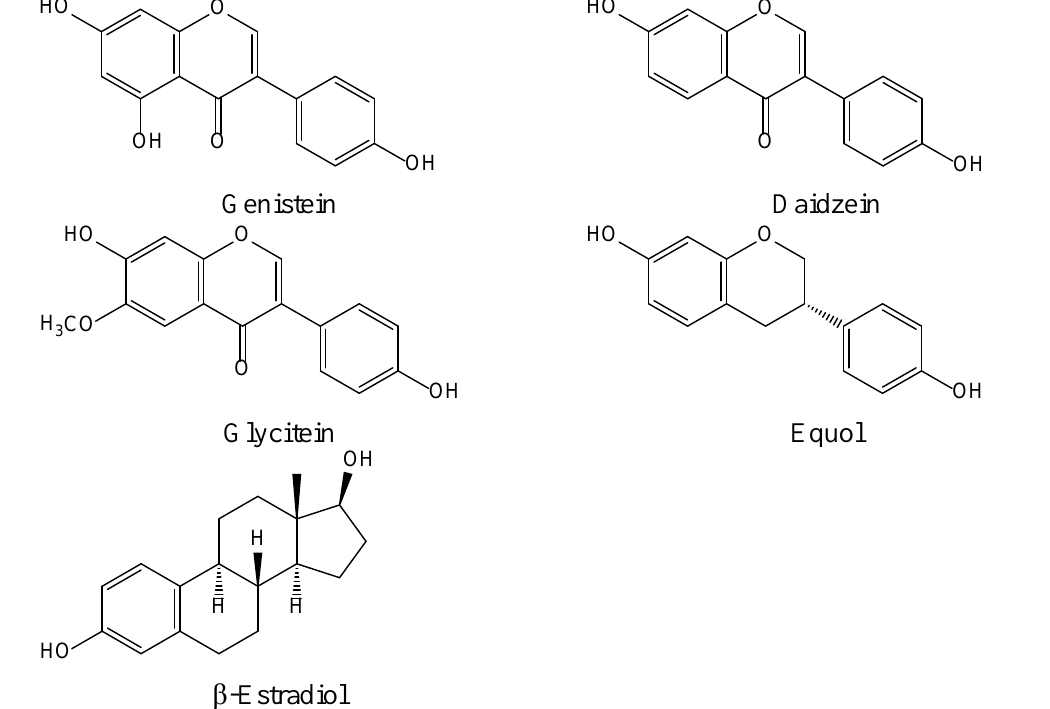
Figure 1. Chemical structures of soy isoflavones (IF) genistein (GEN), daidzein (DAI), glycitein (GLY), and the microbial daidzein metabolite equol in comparison with β-estradiol